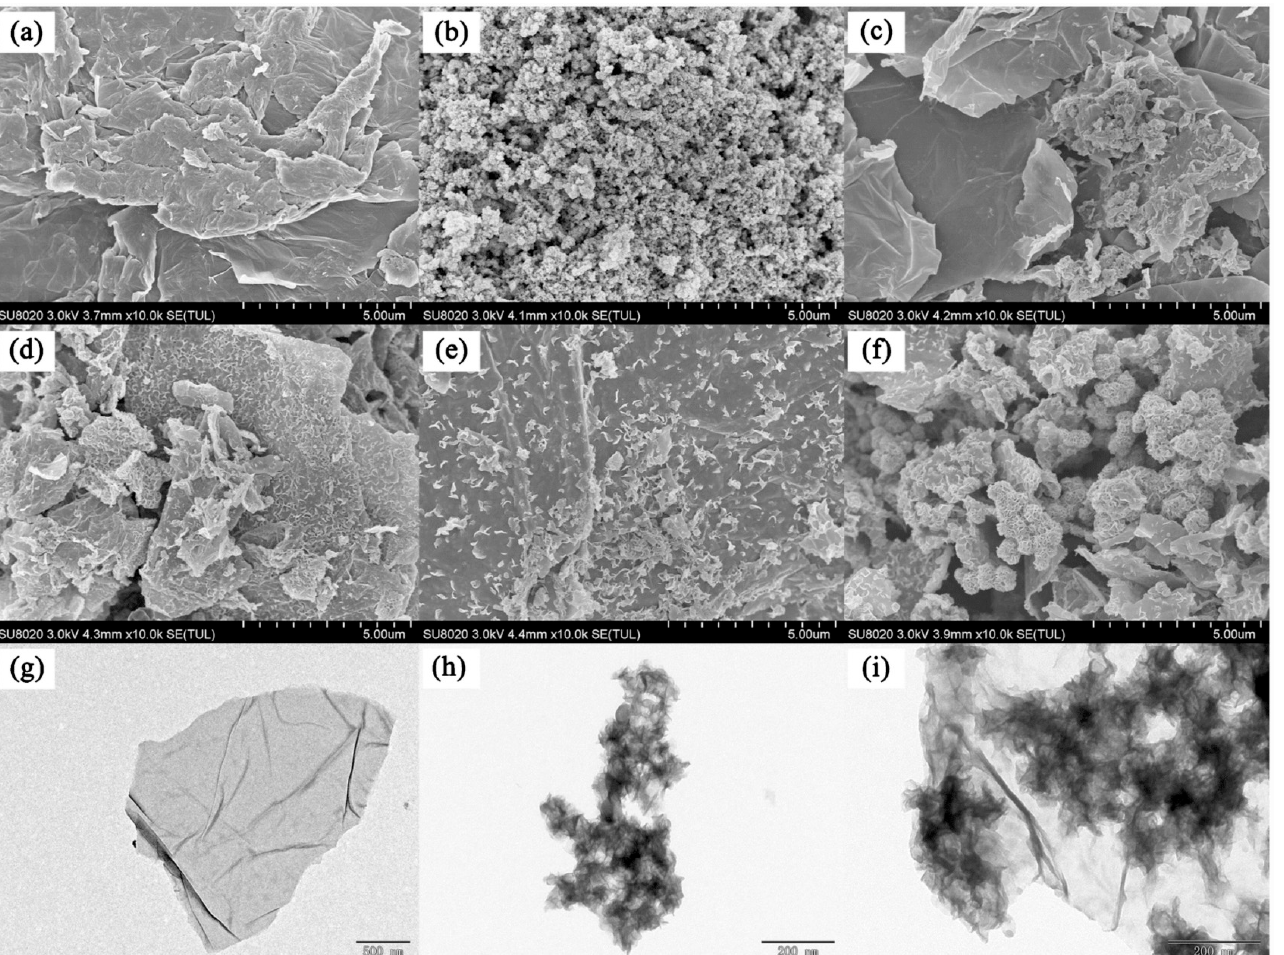
Figure 2. SEM images of GO: ( a ) MoS 2 , ( b ) MoS 2 /GO-0.5, ( c ) MoS 2 /GO-1, ( d ) MoS 2 /GO-1.5, ( e ) and MoS 2 /GO-2. ( f ) TEM images of GO: ( g ) MoS 2 ( h ) and MoS 2 /GO-1.5. ( i ). Reprinted with permission from Ref. [71]. Copyright (2021) Springer Wine.